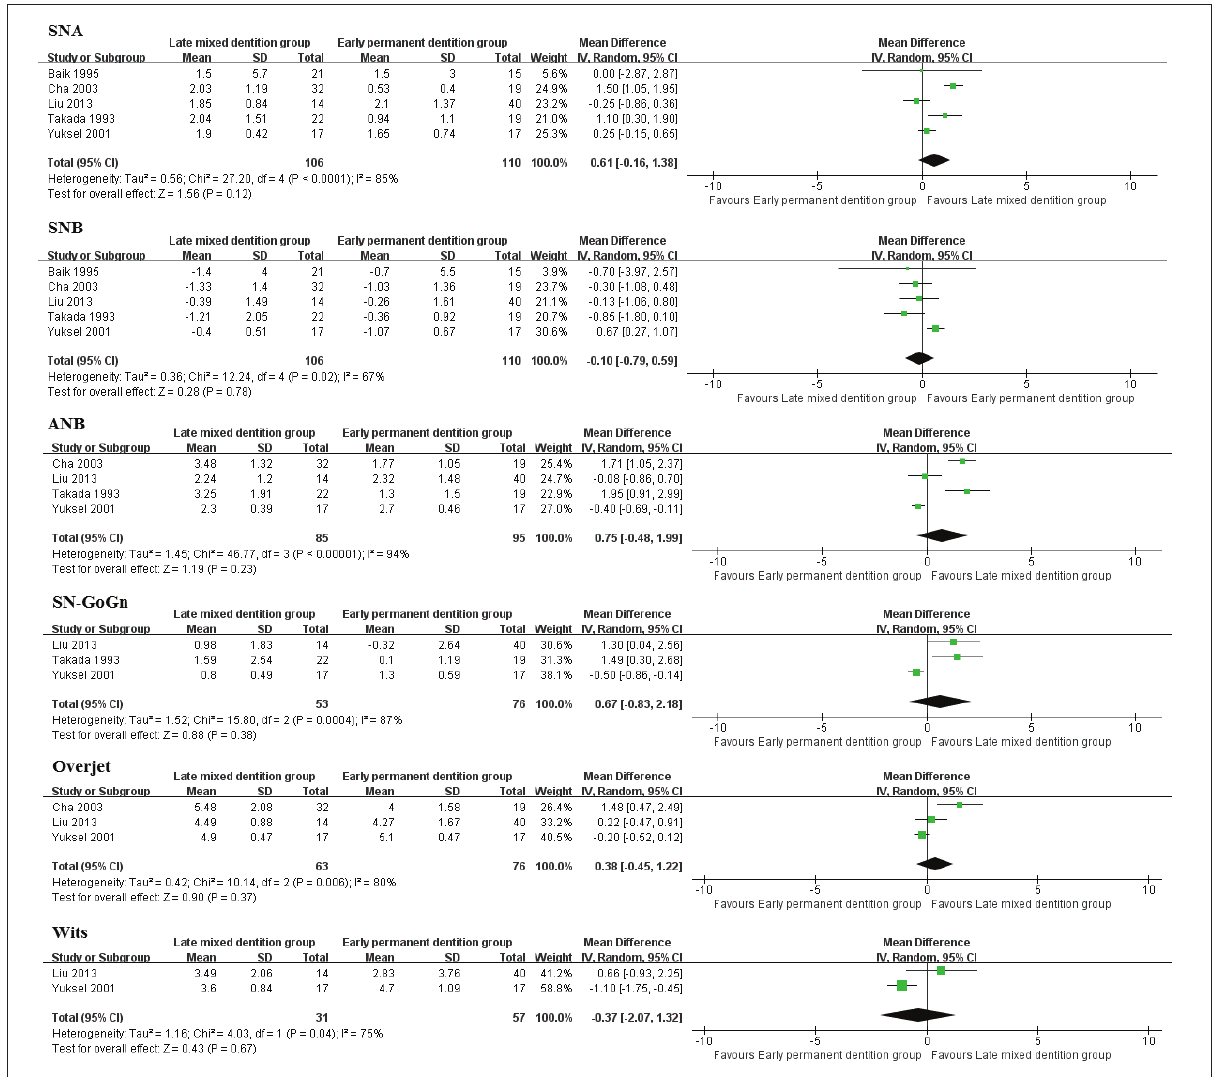
Figure 4. Meta-analysis between late mixed dentition and early permanent dentition. The efficacy assessment of the late mixed dentition group for Class III malocclusion versus the early permanent dentition group. The comparison was per- formed using six indices. 1: Angle SNA. There were no significant differences in SNA between the two groups (MD = 0.61, 95% CI = -0.16 – 1.38, P = 0.12). 2: Angle SNB. There were no significant differences in SNB between the two groups (MD =-0.10, 95% CI = -0.79 – 0.59, P = 0.78). 3: Angle ANB. There were no significant differences in ANB between the two groups (MD = 0.75, 95% CI = -0.48 – 1.99, P = 0.23). 4: SN/GoGn angle. There were no significant differences in SN/GoGn angle between the two groups (MD = 0.67, 95% CI = -0.83 – 2.18, P = 0.38). 5: overjet. There were no significant differences in overjet between the two groups (MD = 0.38, 95% CI = -0.45 – 1.22, P = 0.37). 6: Wits. There were no significant differences in Wits between the two groups (MD = -0.37, 95%CI = -2.07 – 1.32, P =